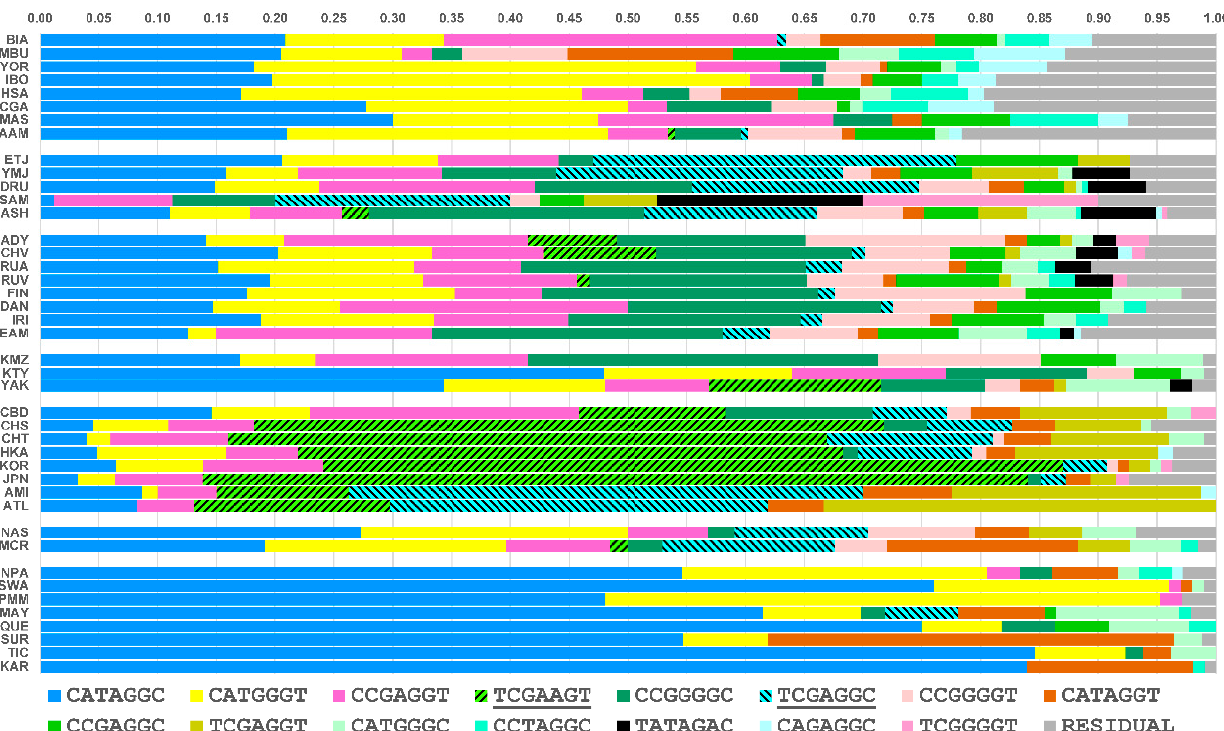
Figure 4. The core haplotype pattern based on seven SNPs (see Table 1) is shown for 42 populations. Haplotype frequencies are highly variable across all geographic regions with Africans displaying the most variation while Native Americans have the least variation. The haplotype TCGAGGC is observed at very common frequencies in Southwest Asians, Ashkenazi, and Ethiopians. In East Asia and the Pacific region this haplotype has comparable frequencies. Another haplotype, TCGAAGT, is predominant in East Asian populations with frequency estimates ranging from 45 to 70% in Han, Koreans, and Japanese. The haplotype TCGA (from TCGAAGT) has shown a signature of recent positive selection in East Asian populations in earlier studies [13–15].